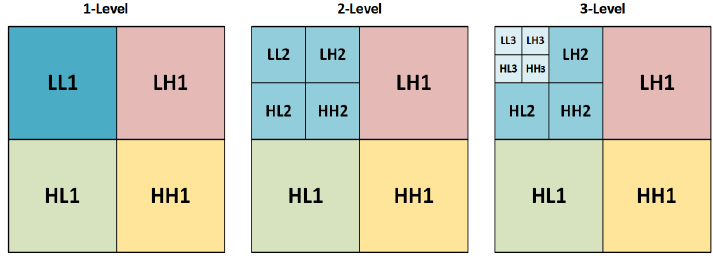
Figure 2. Three levels of DWT decompositions.